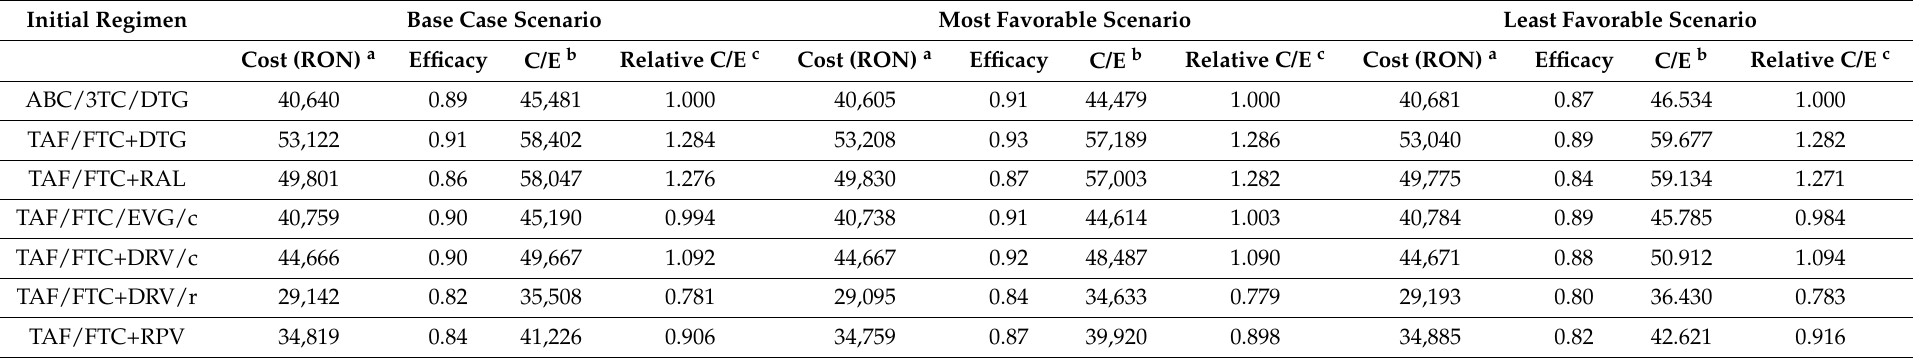
Table 3. Cost/efficacy parameters and relative efficiency at 48 weeks after ART